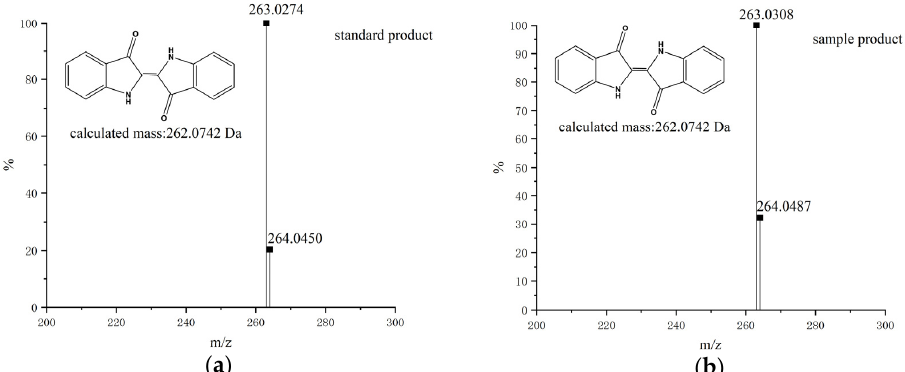
Figure 3. ( a ) After centrifuging the reaction solution of indole, as catalyzed by F87A P450BM3 mutant, the resulting precipitate was redissolved in DMF to obtain a bright blue solution; ( b ) UV-Vis spectra of the authentic indigo sample (black) and the biosynthesized indigo (red) in dimethylformamide (DMF).